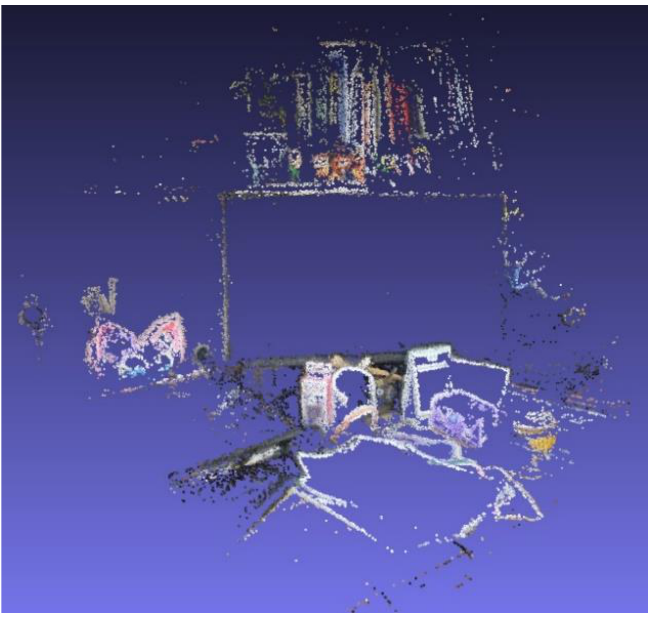
Figure 13. Three-dimensional reconstruction results of images shot by a monocular camera. For the images captured by the bionic compound-eye system, the relative positions of the sub-eye lenses of the system were fixed, and all images obtained by shooting five times could be successfully matched and reconstructed. For the images captured by the monocular camera, some images failed to match with other images, so the reconstruction could not be performed successfully. From the initial input of 54 images, the same number of 45 images could be selected for reconstruction by the program. By comparing the results, the reconstruction of images captured by the bionic compound eye included about 110,000 points, which is better than that of the monocular camera with about 73,000